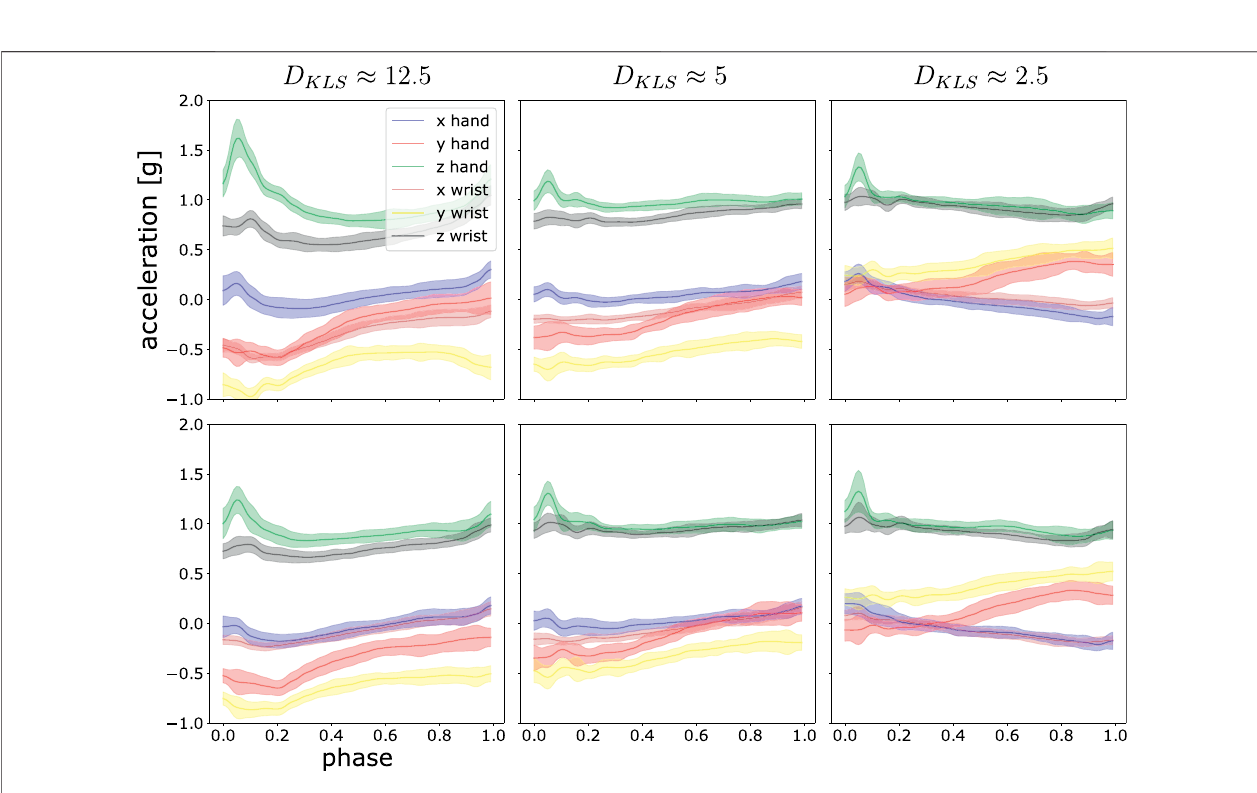
FIGURE2| Thisillustrationsshowsthreeexamplesofthedivergentvalueof D KLS andthedegreeofdifferenceintrajectoryspace.Thepost-processedacceleration pro fi lesare fi ttedbyProMPs,withtheshadedareabeing1 σ con fi dencelevel.Ineachpanel,sixmotiontrajectoriesofhandandwristin x , y and z -axisareshown.Thetop rows are compared with the lower rows to compute D KLS . From left to right, the distance measure D KLS between the two sets is decreasing.